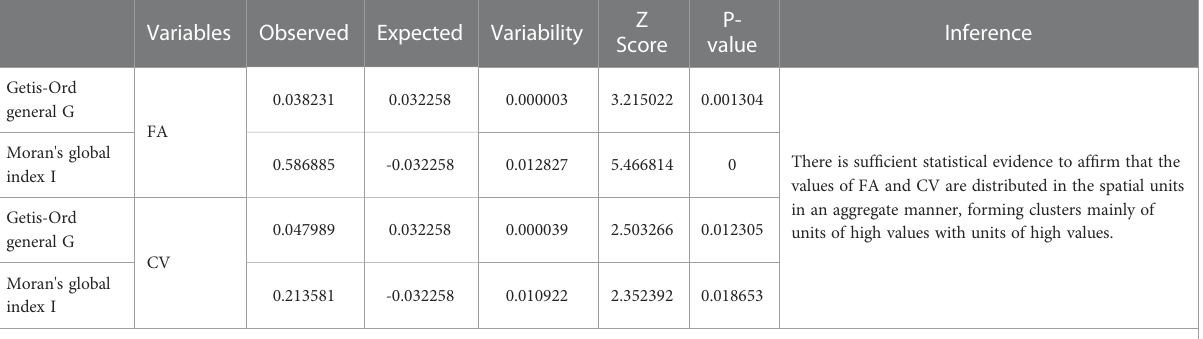
TABLE 2 Inferential statistics for autocorrelation and FA and CV